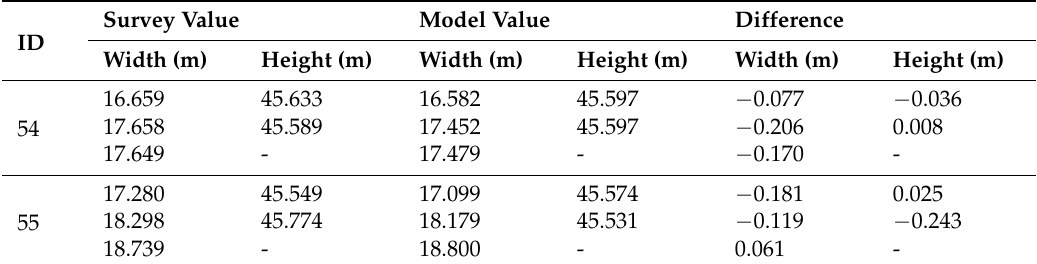
Table 9. Comparison of relative model accuracy of power pylons.